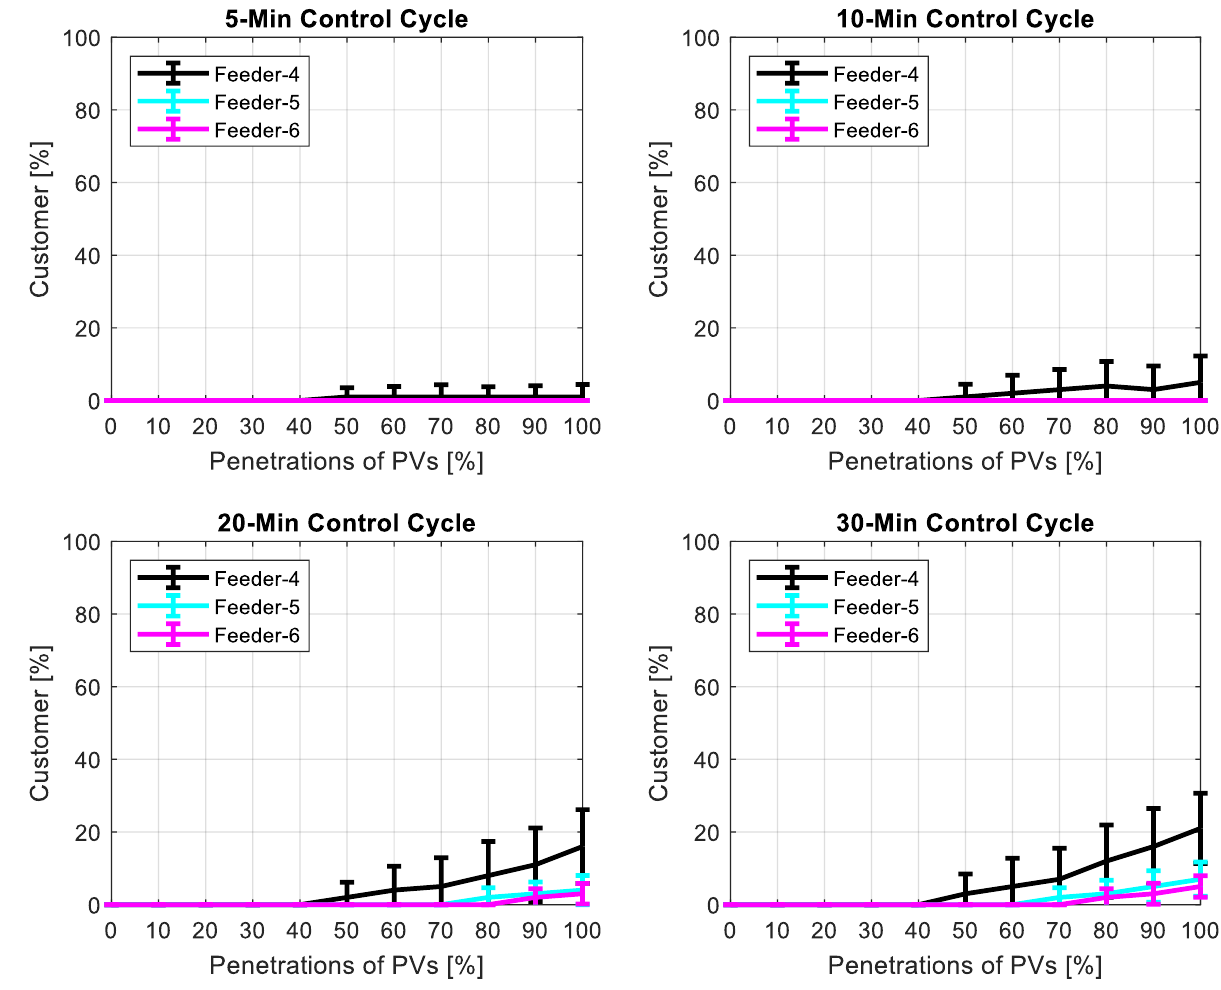
Figure 9. Hosting capacity for different control cycles.